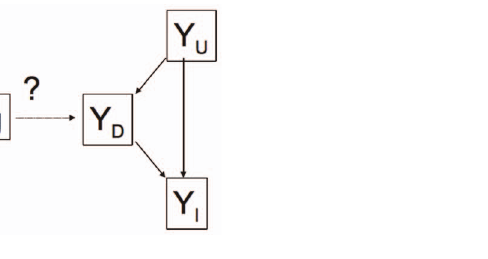
Figure 2. A graphical representation of the model correspond- ing to a partition c ~ ( U , D , I ) . Each of the nodes Y U , Y D , Y I represents a subset of the measured phenotypes Y . The simplest interpretation of the graph is as representing causal relationships among variables. In this interpretation a directed arrow from one node to another represents a direct causal effect, so, for example, the genotype has a direct causal effect on the variables Y D , which in turn affects Y I . A more flexible interpretation is in terms of the conditional independencies among variables that would result from such causal network. The rules for obtaining these conditional independencies involve the notion of d -separation [63], which we do not go into here. Instead we simply note that the conditional independencies encoded by this graph include C 1 : Y U is independent of g ; and C 2 : Y I is conditionally independent of g given Y U , Y D (because all paths from g to Y I go through Y U or Y D ). Note that the absence of any arrows in the direction from Y to g is justified by our treating g as a randomized intervention. (For those familiar with Directed Acyclic Graphical (DAG) models, here each Y node represents a collection of variables, and we allow for arbitrary correlations among the variables within each node. Thus, in a full DAG representation arrows would exist between all pairs of Y variables: arrows between variables in different nodes would go in the direction indicated by the figure. Arrows between variables within a node could go in any direction, subject to the constraint that the resulting graph must be